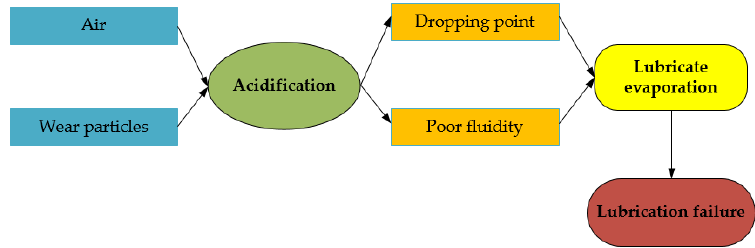
Figure 10. Chemical factors of lubrication failure [99,103].